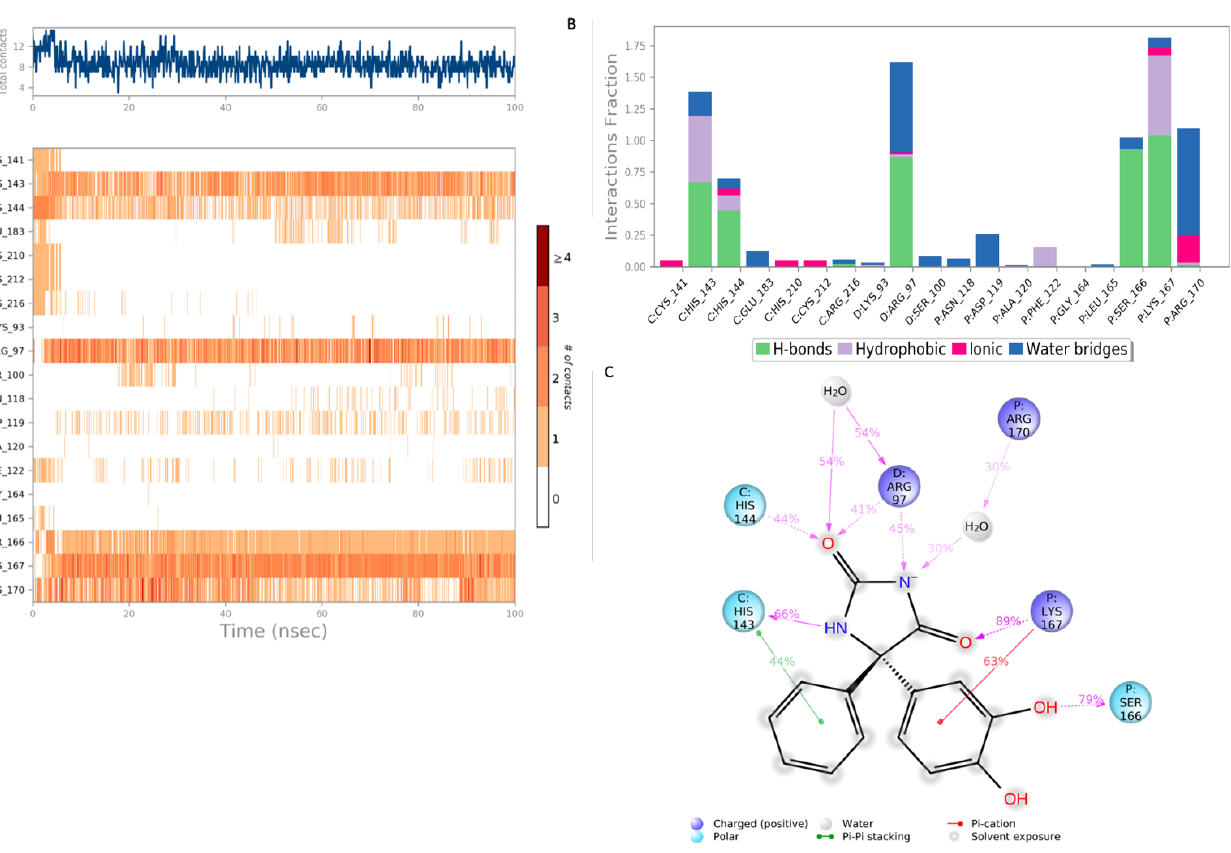
Figure 7. Interaction diagram of phenytoin catechol with the GTPCH1-binding pocket. ( A ) Interaction of phenytoin catechol with residues in each trajectory frame. The depth of color indicates the level of interaction with contact residues; ( B ) the protein–ligand contacts show the bonding interaction fractions and the nature of the interactions; ( C ) graphical 2D illustration of phenytoin catechol interacting with the protein residues during MD simulation. Interactions shown occurred over 30% of the simulation time. C—chain C of the GTPCH1-binding pocket; D—chain D of the binding pocket; P—chain P of the binding pocket.